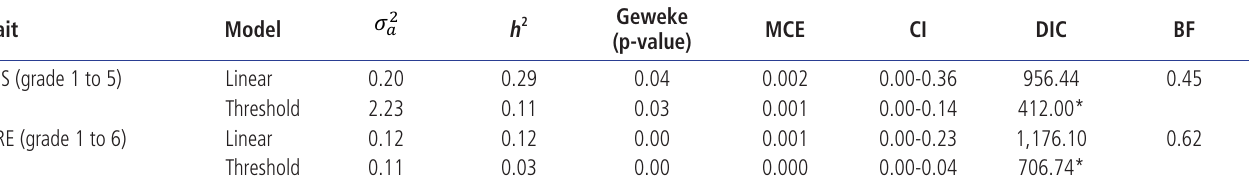
Table 2. Additive variance estimates and heritability (h²) of categorical characteristics body condition score (BCS) and the loin marbling (MRE), obtained from analysis with linear model and threshold model Trait